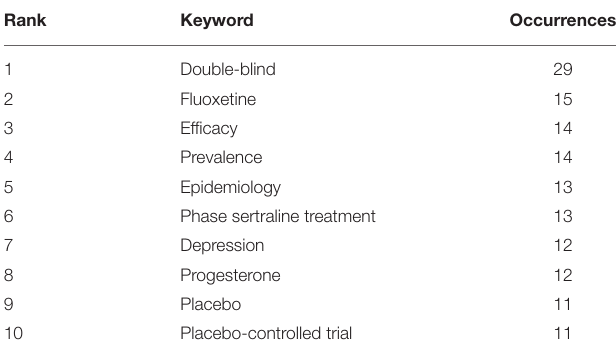
TABLE 2 | Top 10 research directions identified in the 100 most cited papers on PMS/PMDD.